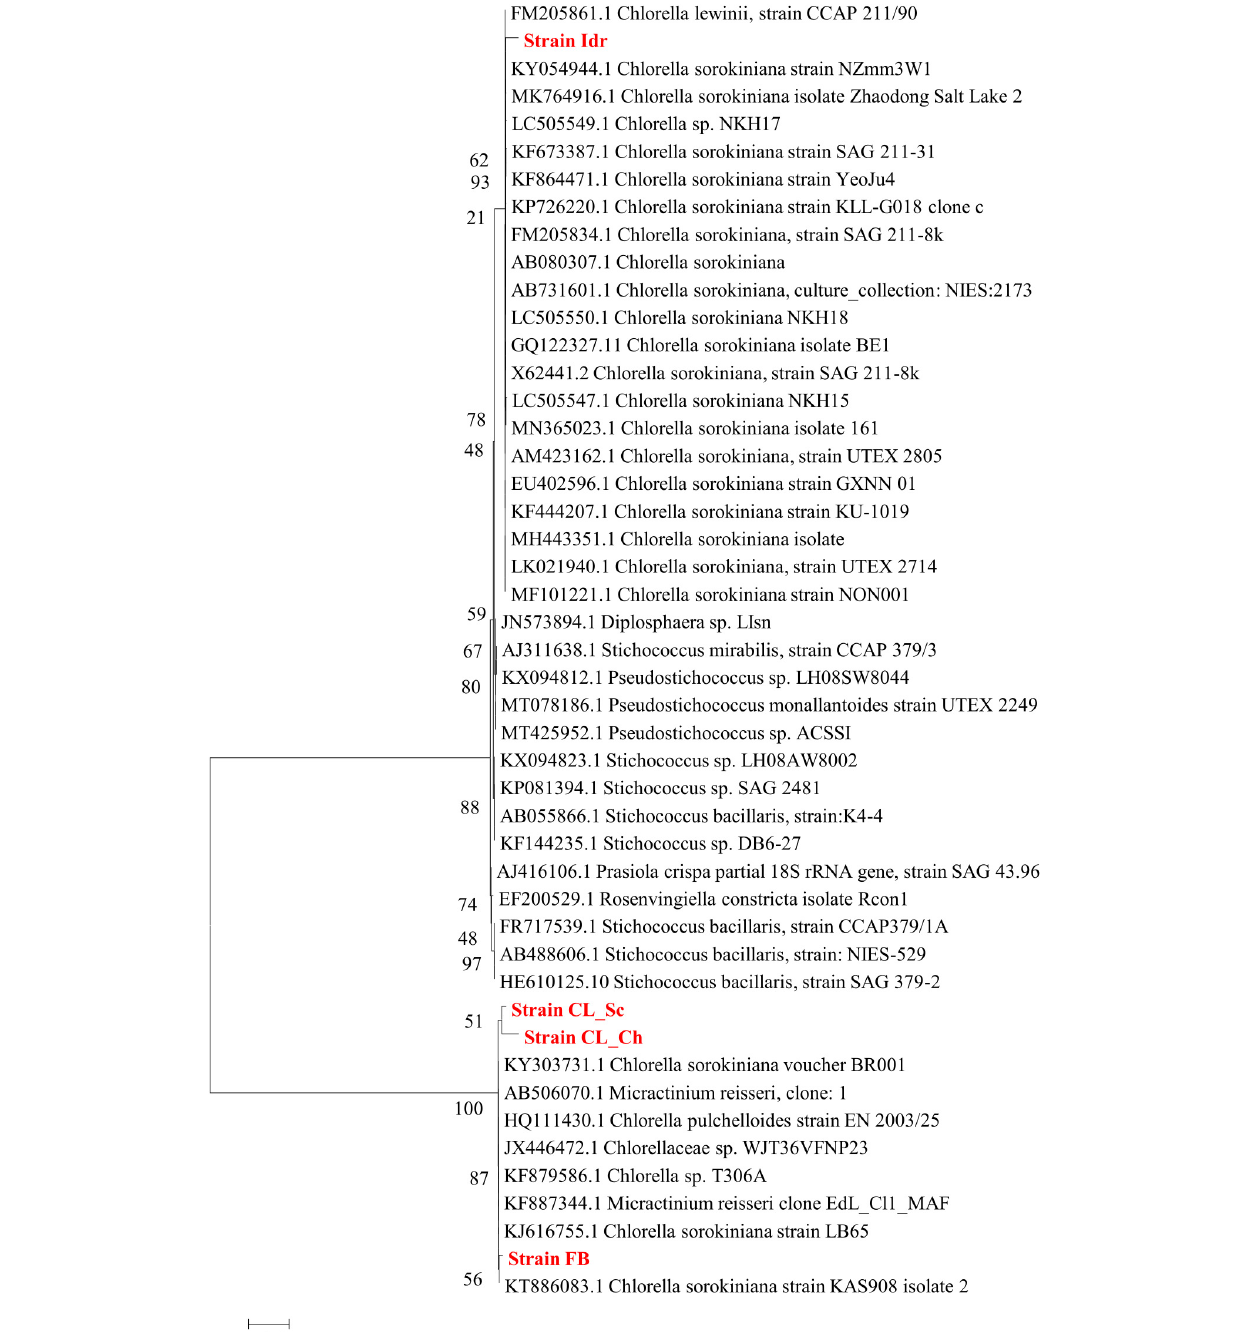
absence of every drug/test. The parameters compared to assess the growth in 1 week were O.D. (750 nm), total chlorophyll content and carotenoids. To this purpose, comparison between